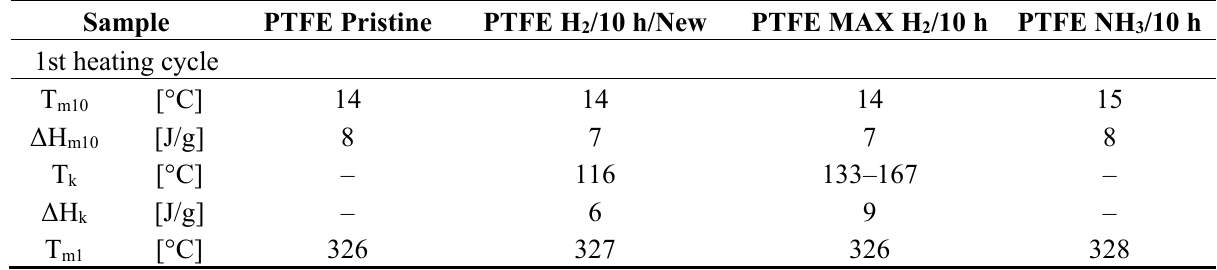
Figure 6. DSC curves of 1st heating cycles of ( a ) H 2 plasma treated PTFE sample. ( b ) NH 3 plasma treated PTFE sample. ( c ) MAX H 2 plasma treated PTFE powders. The expanded curves on the left show the post-crystallization peaks observed for the plasma treated samples. Table 2. Summary of various differential scanning calorimetric values of different PTFE samples.